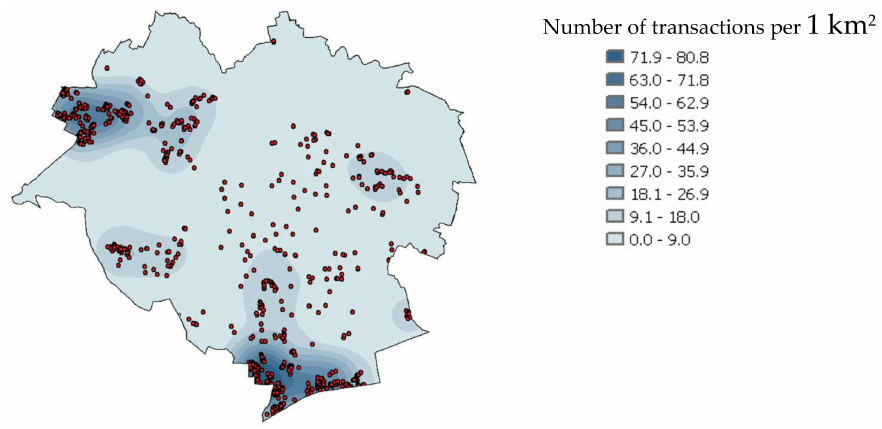
Figure 3. The spatial distribution of the input data for simulation of transactions in a real estate market (the points show the centroids of plots as transaction objects).